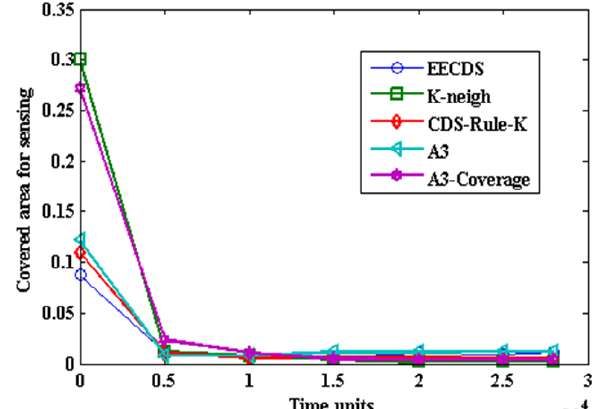
Figure 10. Network lifetime for sensing coverage